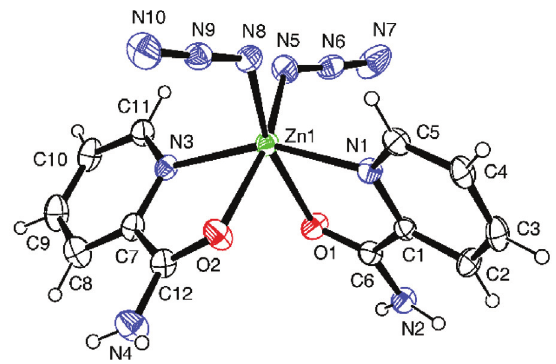
Figure 2a. Molecular structure of 3 with the atom numbering sche- me.